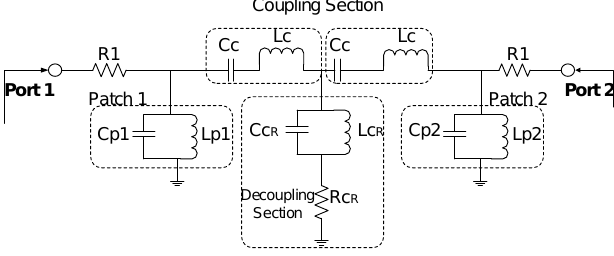
Figure 5. Equivalent Circuit Model of the proposed MIMO antenna.